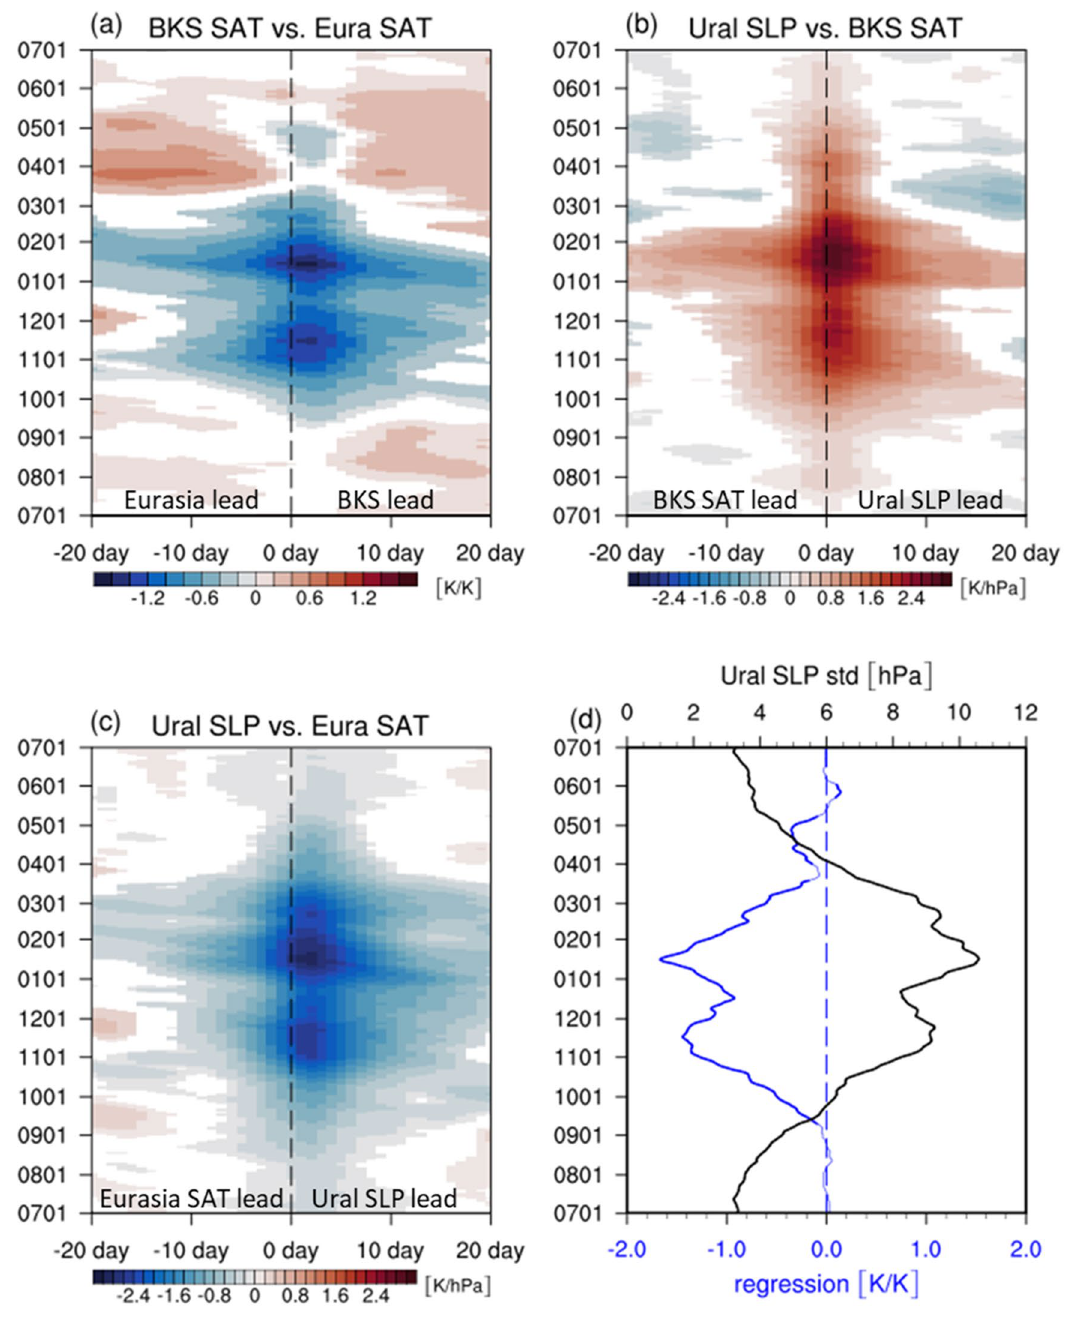
Figure 1. ( a ) Lead–lag regression coefficients of BKS and Eurasian SAT anomalies during the period of 1980–2016. Same as ( a ) but for ( b ) Ural SLP and BKS SAT anomalies, ( c ) for Ural SLP and Eurasian SAT anomalies. The y-axis is the starting day of the 30-day combined time series and the x-axis is the time lag. Only the values that are statistically significant at the 95% confidence level are shaded. ( d ) Regression coefficient (blue) at 2 days in ( a ) and the standard deviation of Ural SLP anomalies (black). Figures were created with the NCAR Command Language 6.6.2 (http://dx.doi.org/10.5065/D6WD3